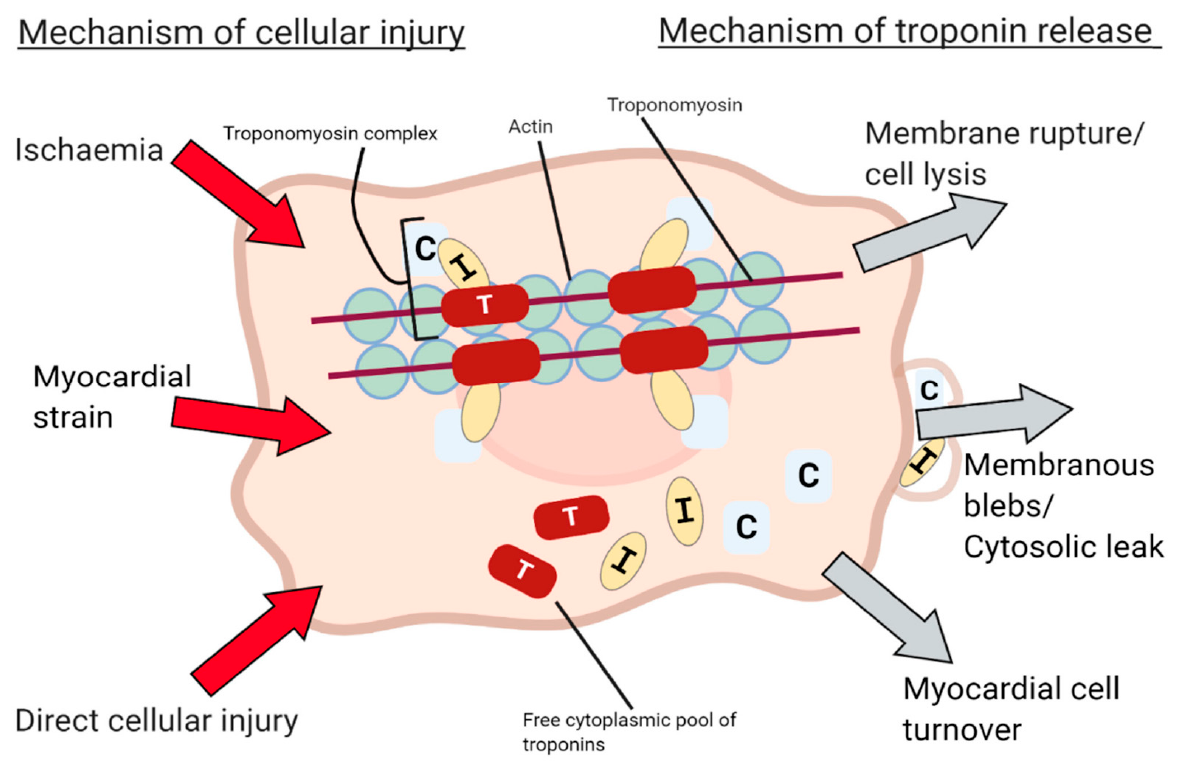
Figure 2. Mechanisms of Troponin release. From Taggart et al. [ 14 ].